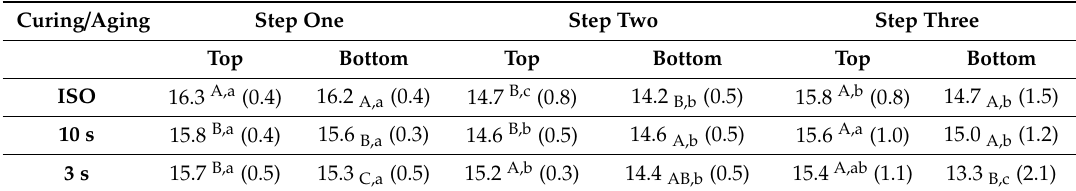
Table 3. Depth-sensing indentation test: indentation modulus Y in GPa (mean and standard deviation). Superscript / subscript letters indicate homogeneous groups; Capital letters indicate sub-groups related to columns; Lowercase letters indicate sub-groups related to rows; Tukey’s post-hoc test ( α = 0.05). Curing / Aging